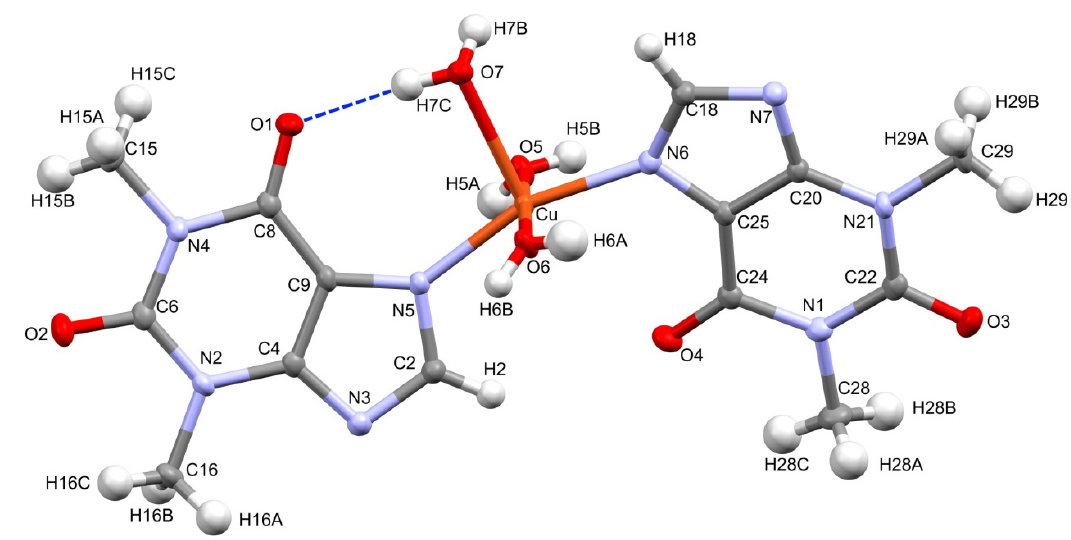
Figure 1. Molecular structure of 1 . Conserved waters O8 and O9 are omitted for clarity. Displacement ellipsoids are drawn at the 50% probability level. Hydrogen atoms are represented by spheres of an arbitrary radius. Intramolecular hydrogen bond is shown with a broken line in blue.